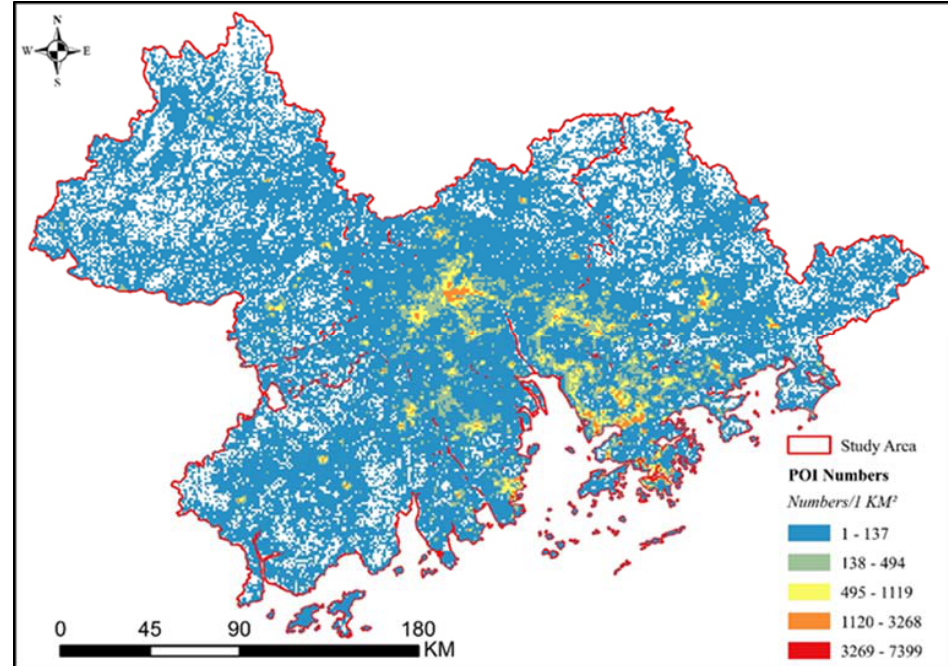
Figure 3. Spatial distribution of POI data in the GBA. The population migration data were obtained by accessing the Tencent location big data platform and randomly selecting 12 weeks of population migration data in the GBA from 1 January to 31 December 2020. Data attributes include origin and destination point, longitude and latitude, population inflow, population outflow, and the migration ratio of different modes of transportation. Finally, we uniformly resampled the data to a spatial resolution of 130 m (Figure 4). The details of the accessed data are listed in Table 1.